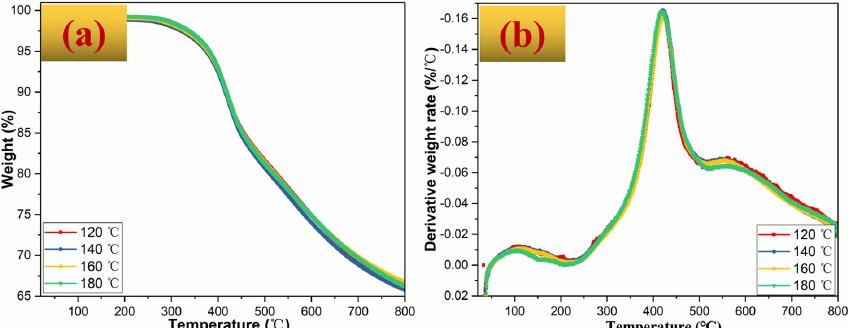
Figure 8. ( a ) TGA and ( b ) DTG curves of BZPN foams. Table 3. Thermal properties of BZPN foams at various foaming temperatures. Foaming